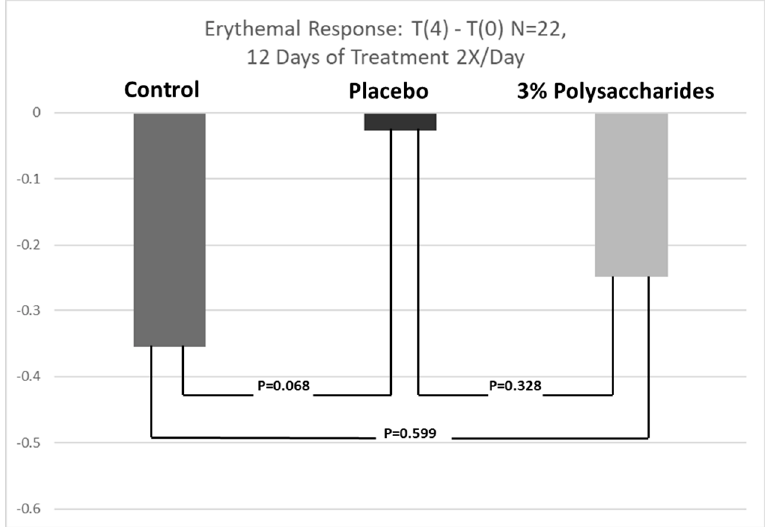
Figure 3. Results of erythema measurements. Dark grey is the untreated control, black is the retinol placebo-treated and light grey is the polysaccharide active-treated sites. N = 22, p ≤ 0.05.